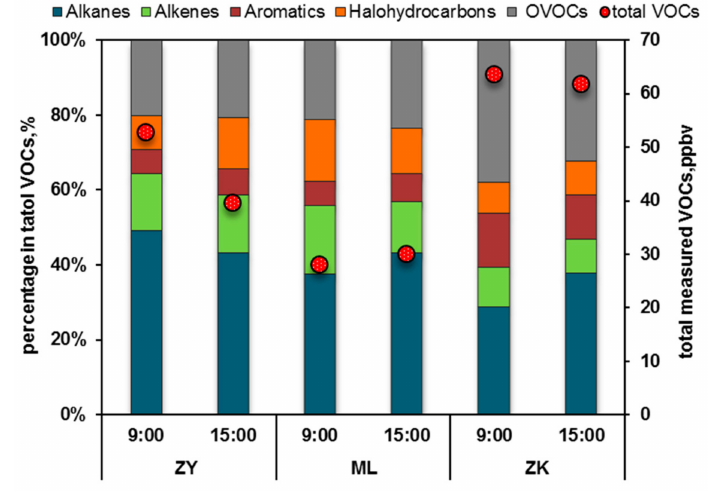
Figure 2. Regional distribution of the mixing ratio and total VOCs measurement at the three